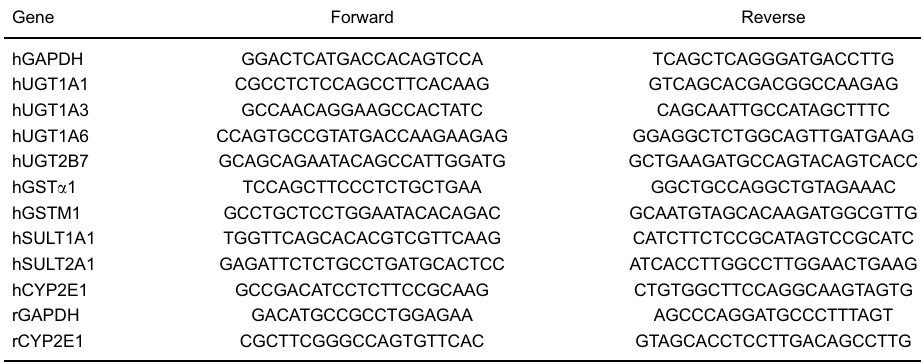
Table 1. Primers used in this